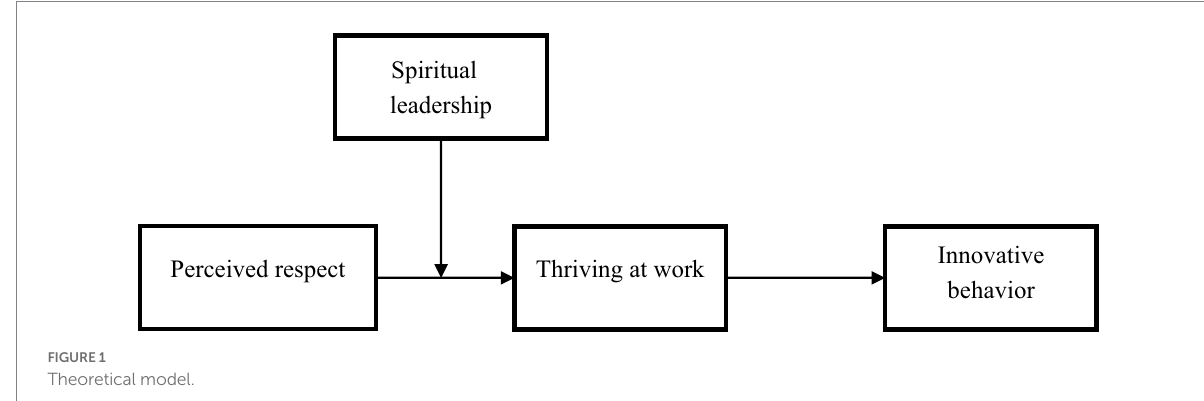
FIGURE 1 Theoretical